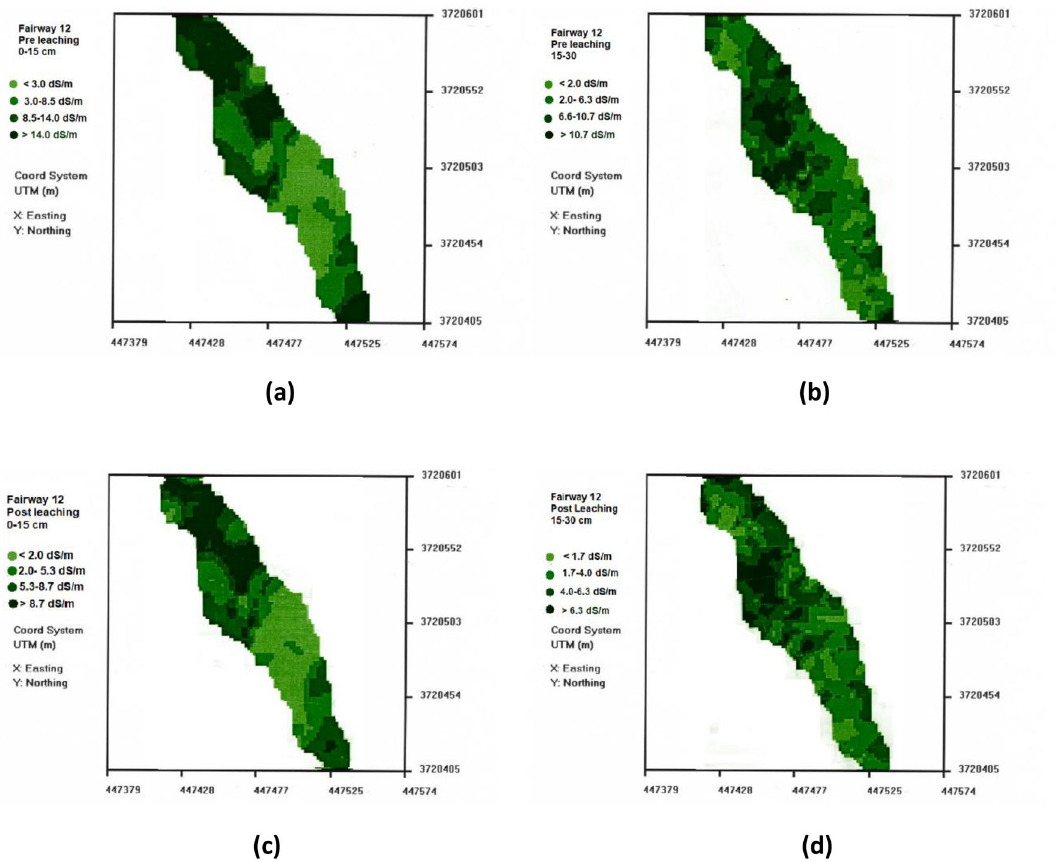
Figure 2. Pre-leaching ( a ) 0–15 cm, ( b ) 15–30 cm and post leaching ( c ) 0–15 cm, ( d ) 15–30 cm salinity maps (ECe) for fairway 12 created using ESAP.